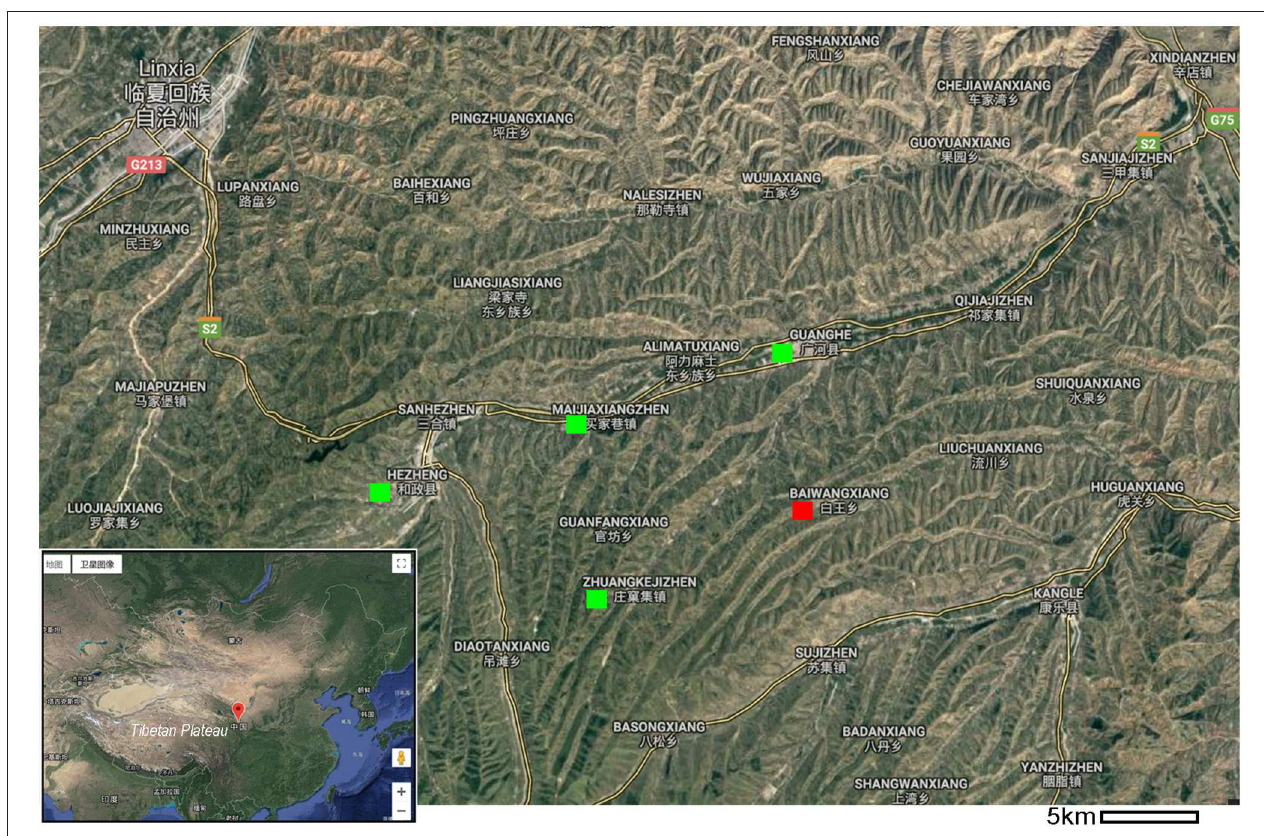
FIGURE 1 | Map of the holotype locality of Linxiavis inaquosus and other nearby fossil bird localities in central China adjacent to the Tibetan Plateau. The red box indicates the holotype locality for the new sandgrouse, and the green boxes mark previously published fossil bird sites (e.g., Hezheng, Guanghe).